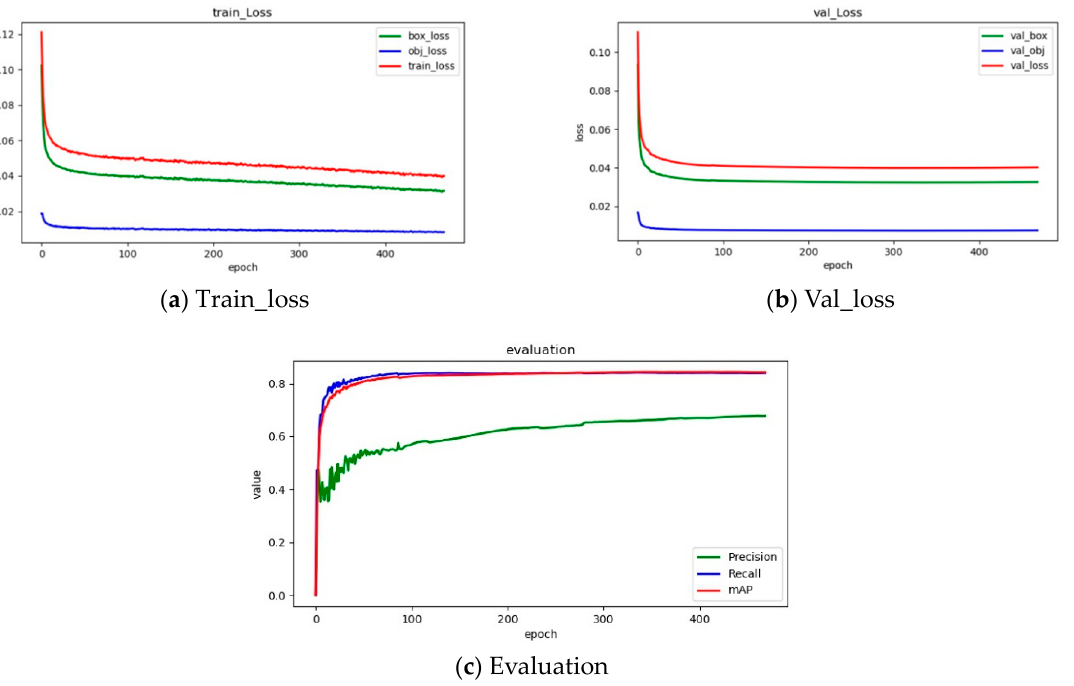
Figure 6. Changes in loss and evaluation index values. Table 2. Comparison with the typical method based on the rectangle